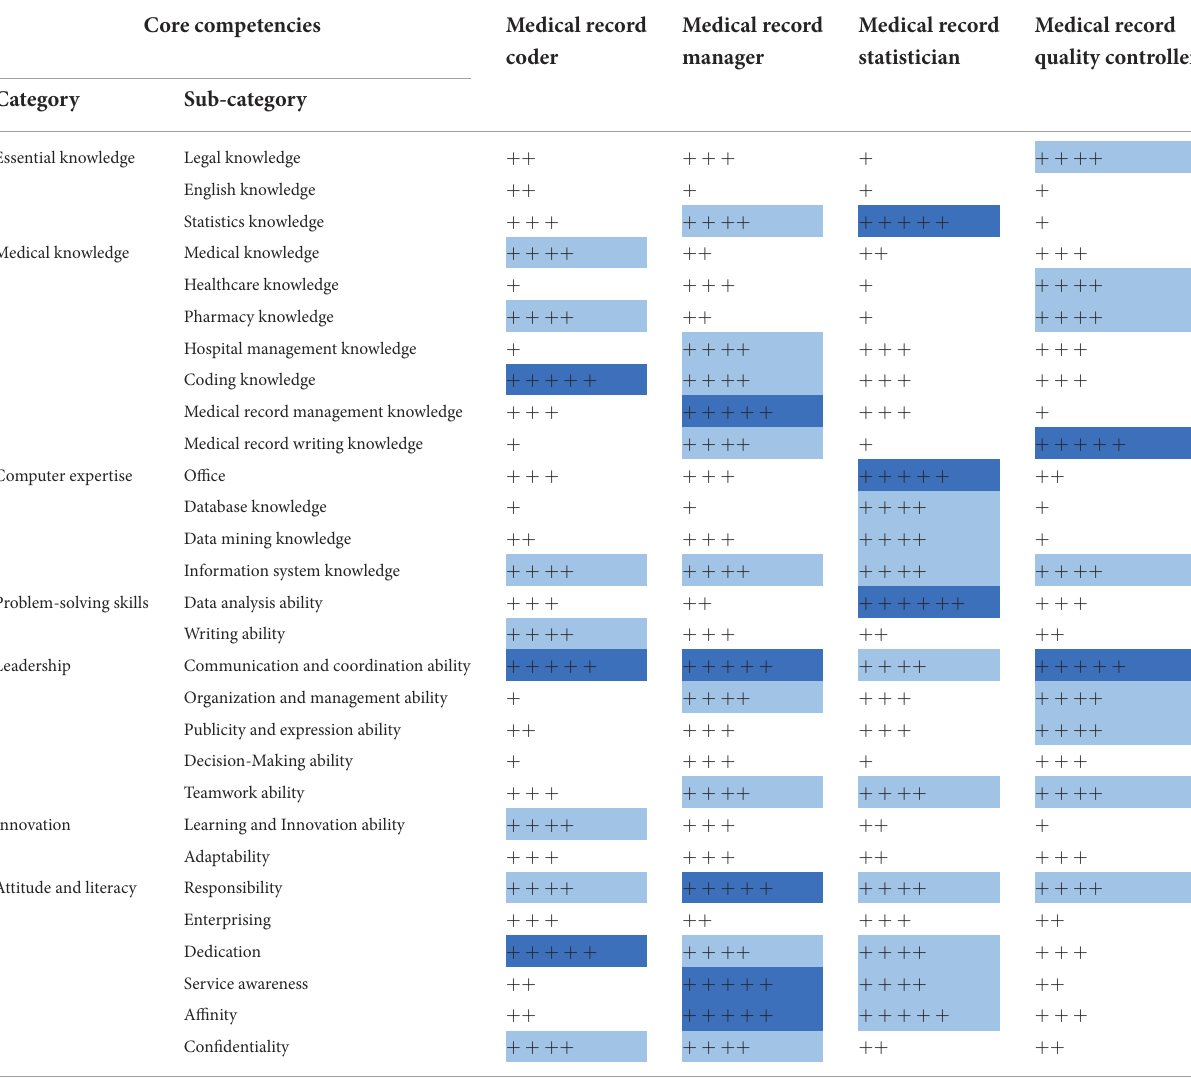
TABLE 5 Core competencies of medical record information